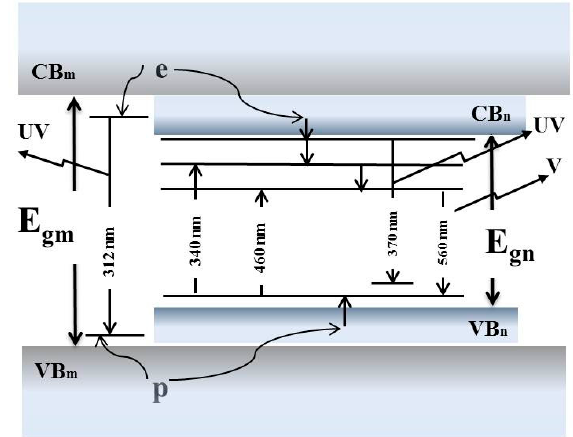
Figure 10. Model representation of the band structure of phosphor with nanodefects.